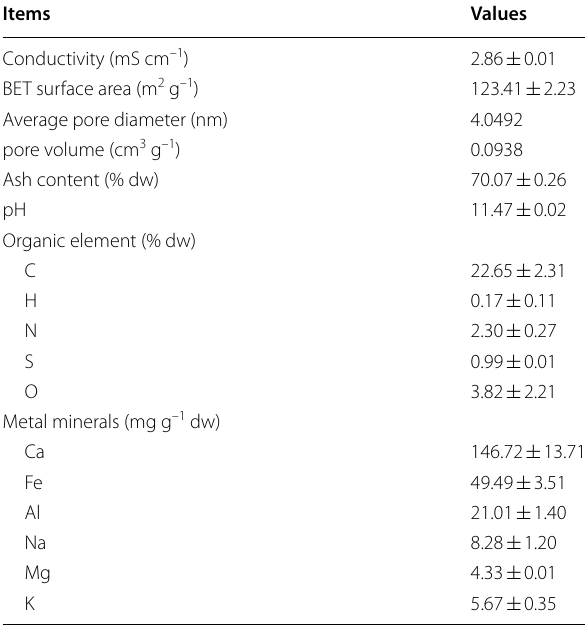
Table 1 Physicochemical properties of the